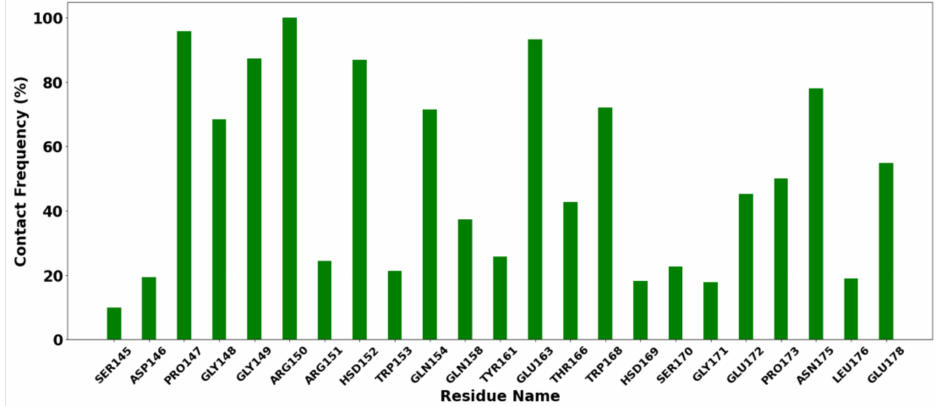
Figure 8. Histogram of contact frequency analysis with a cutoff of 4 Å.